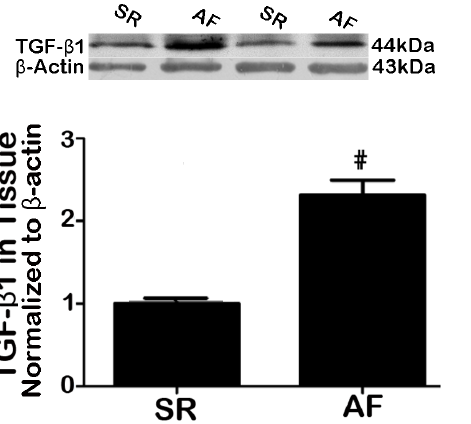
Figure 2. Comparison of TGF- b 1 protein levels between AF and SR tissues. Upper panel: representative analog data of Western blot bands; lower panel: averaged analog data of Western blot bands (band density), normalized to b -actin. # P=0.00 vs. SR, { P=0.02 vs. SR; n=10.